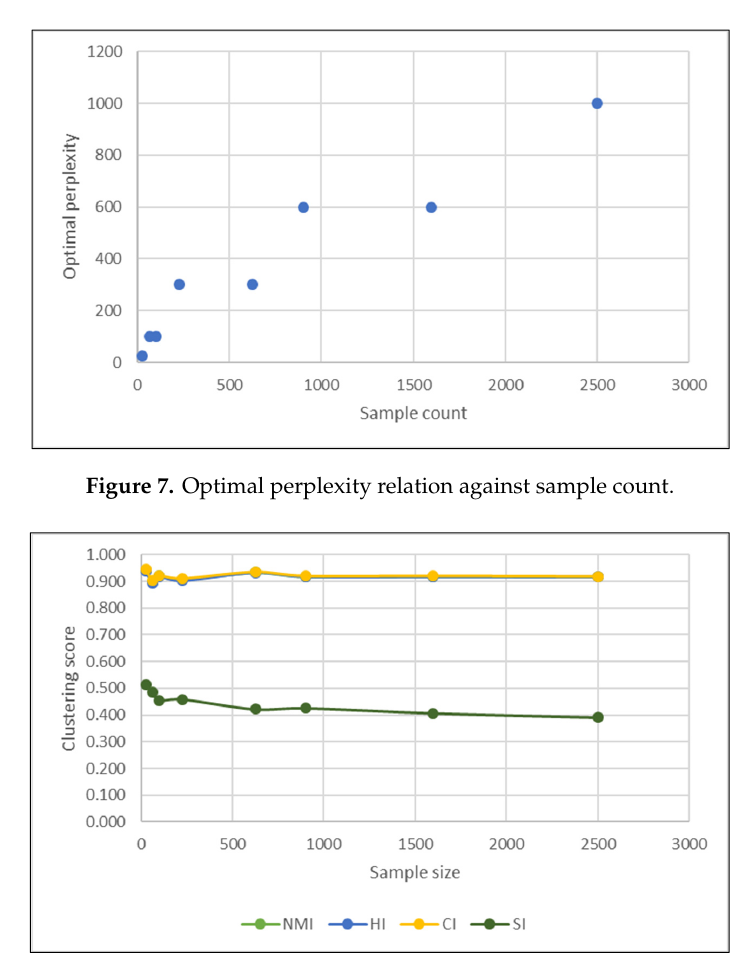
Figure 8. Impact of sample size over the clustering index for the t-SNE algorithm.